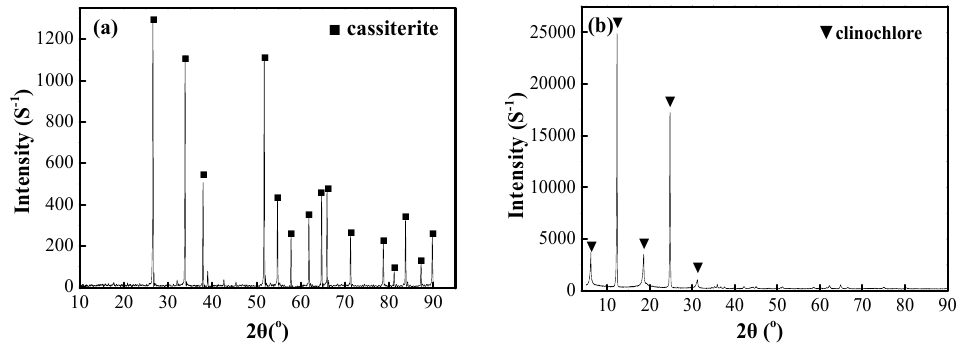
Figure 1. X-ray powder diffraction (XRD) patterns of samples: ( a ) cassiterite; ( b ) clinochlore.